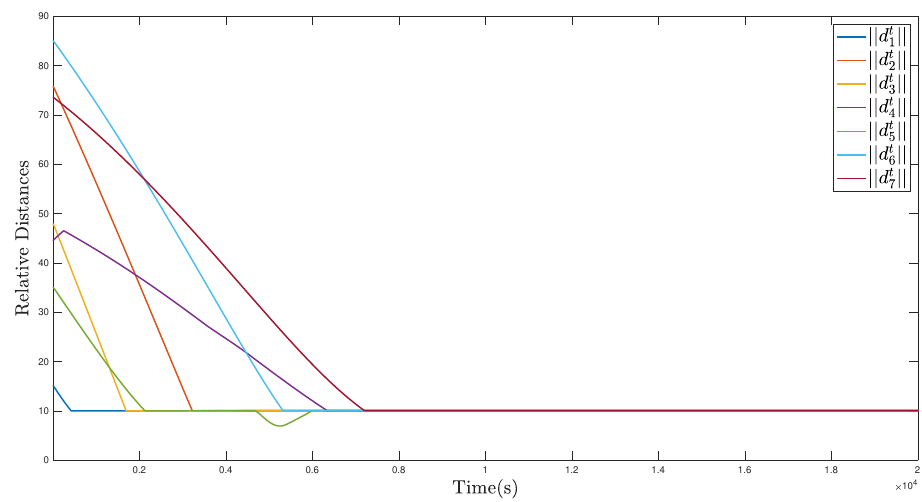
Figure 16. Relative distances between the MSAs system members and the moving